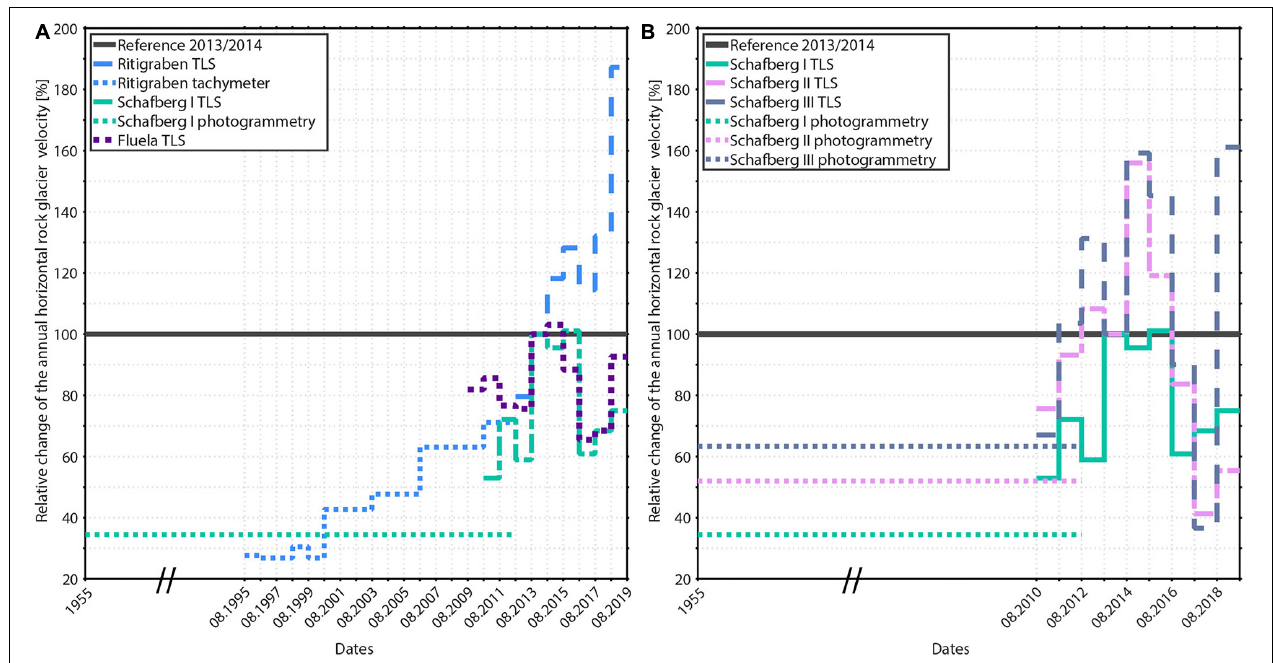
FIGURE 14 | Mean annual horizontal rock glacier velocity in [%] relative to the reference period 2013/2014 at (A) the ice-rich rock glaciers Fluela, Schafberg I and Ritigraben from 1955 to August 2019. (B) The three different rock glacier sections I, II, and III of the Schafberg complex. Data is derived from TLS since 2010. Earlier velocities are from swisstopo airborne images (photogrammetry) at Schafberg rock glacier and from tachymeter observations (data from Rovina & Partner AG) at Ritigraben rock glacier. Irregular tachymeter observations are shown for completeness and are discussed in Kenner et al. (2017a). Please note that the x -axis scale is not linear between 1955 and 2012, as indicated by the two